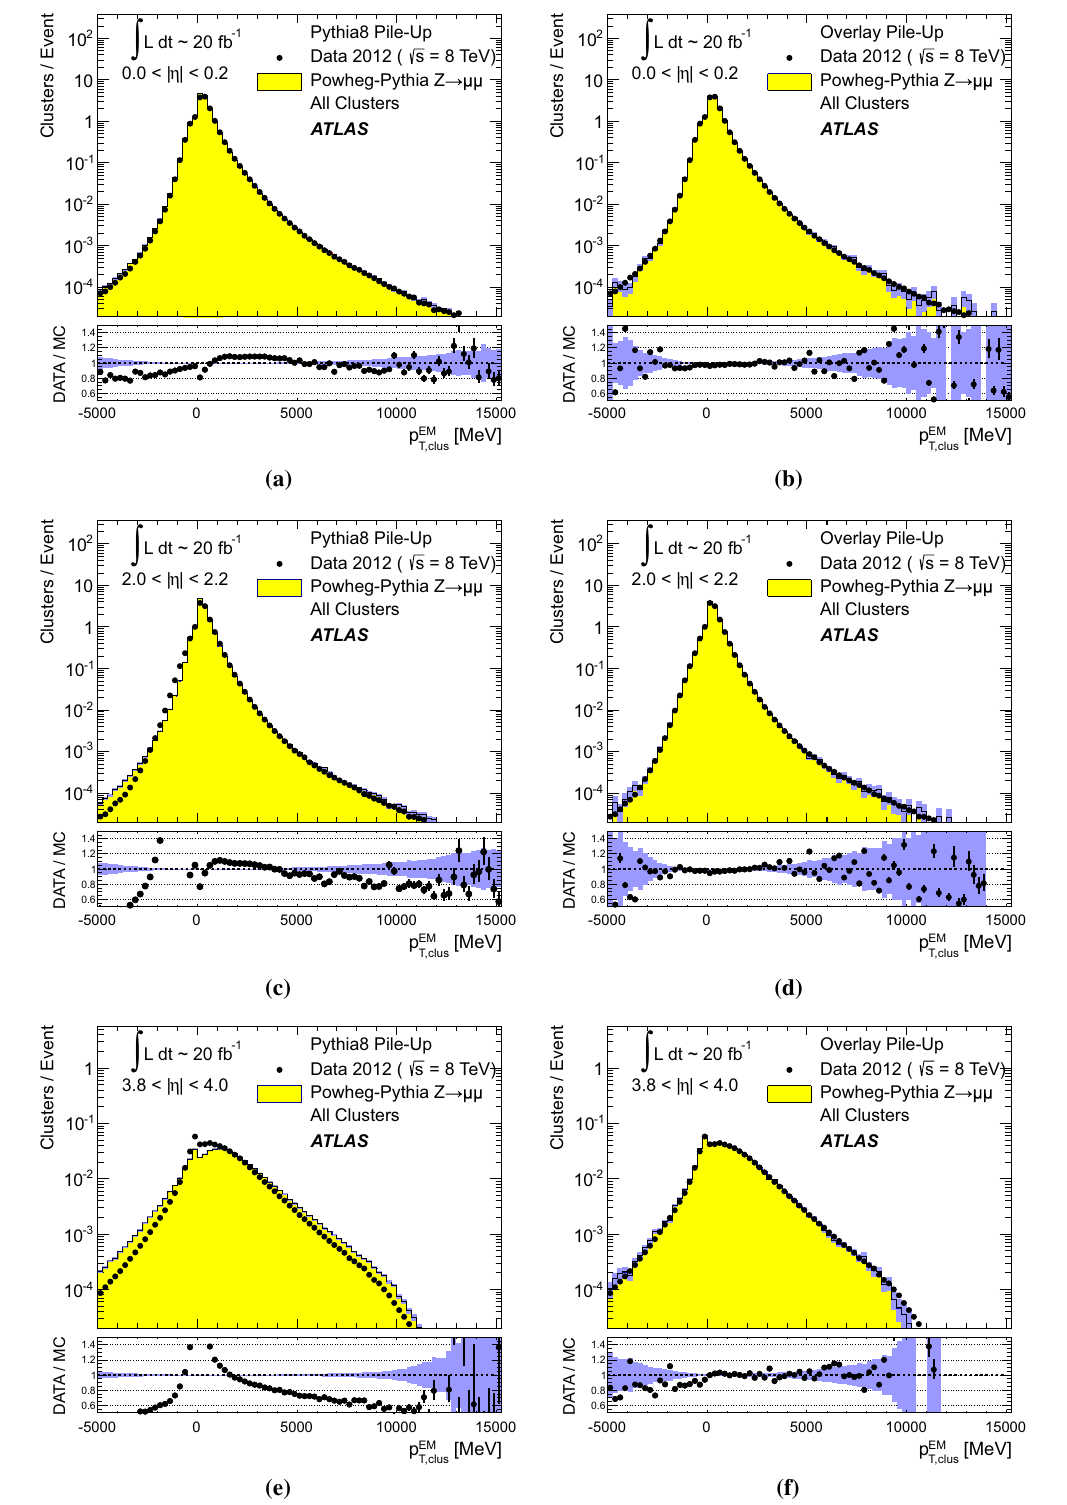
| < 0 . 2, ( c , d ) 2 . 0 < | η | < 2 . 2 , ( e , f ) 3 . 8 < | η | < 4 . 0. | η clus clus clus The ratio of the distribution from data to the one from MC simulation is ) for an inclusive Z → μμ T , clus evaluated bin-by-bin and shown below the respective distribution. The shaded bands indicate the statistical uncertainties from MC simulations for both the spectra and the